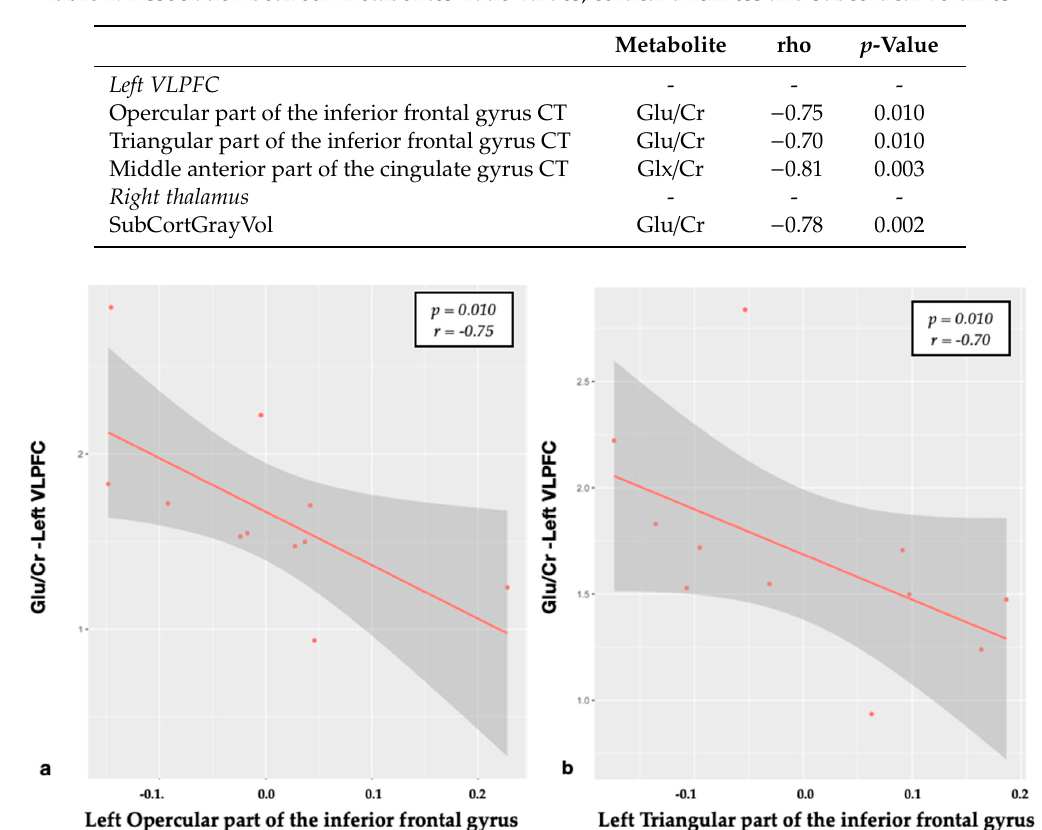
Table 2. Association between metabolites’ ratio values, cortical thickness and subcortical volumes.